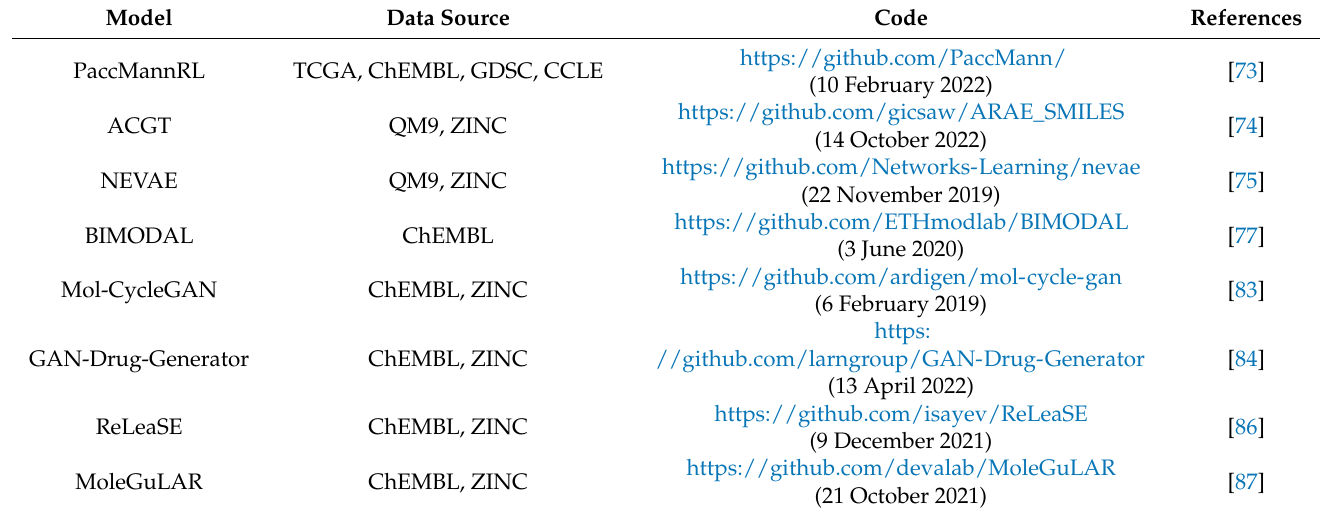
Table 4. Methods for de novo anti-cancer drug design through artificial